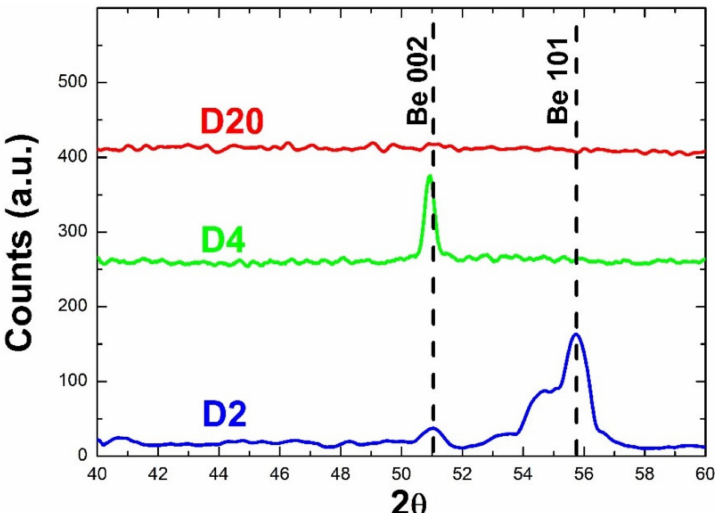
Figure 3. XRD diffraction patterns of the Be-D layers (D2, D4 and D20) deposited at 343 K on silicon